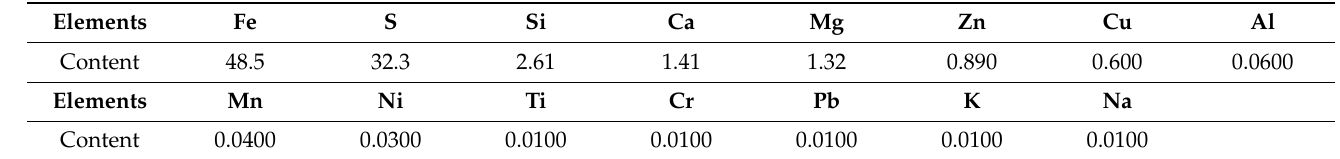
Table 3. Main chemical constituents of sulfide concentrate